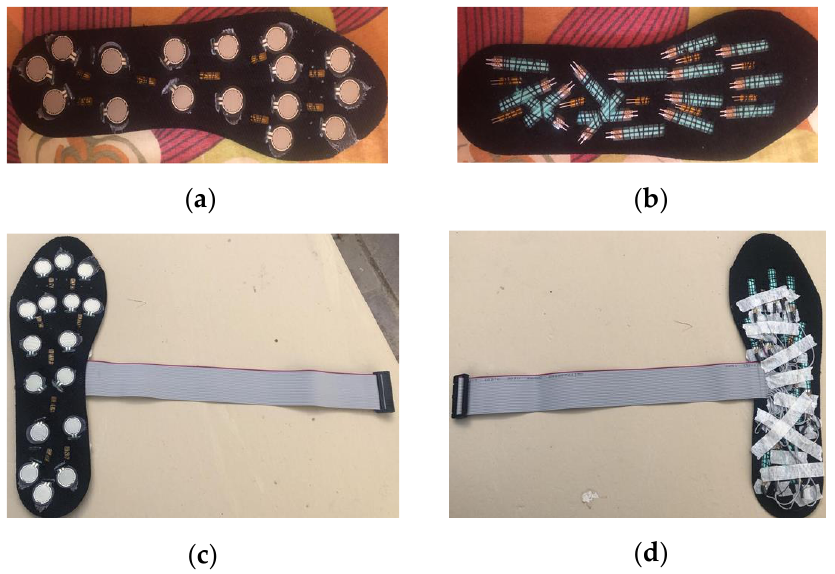
Figure 12. ( a ) FSRs and Temperature sensors glued to the front end of the insole; ( b ) Bottom side of the insole; ( c ) The complete insole after being soldered to the ribbon cable (Top Side); ( d ) Bottom Side of the completed insole.